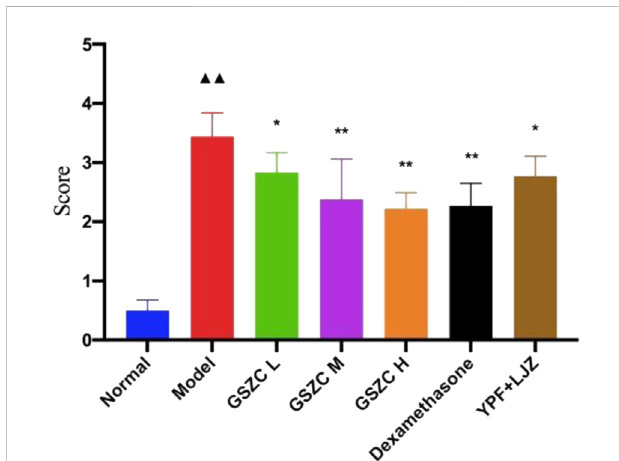
FIGURE 7 Effects of GSZC granules on lung histopathological score in rats suffering from asthma. Values are the mean ± SD, n = 6 for each group. ▲▲ p < .01 versus the normal group, * p < .05, ** p < .01 versus the model group.